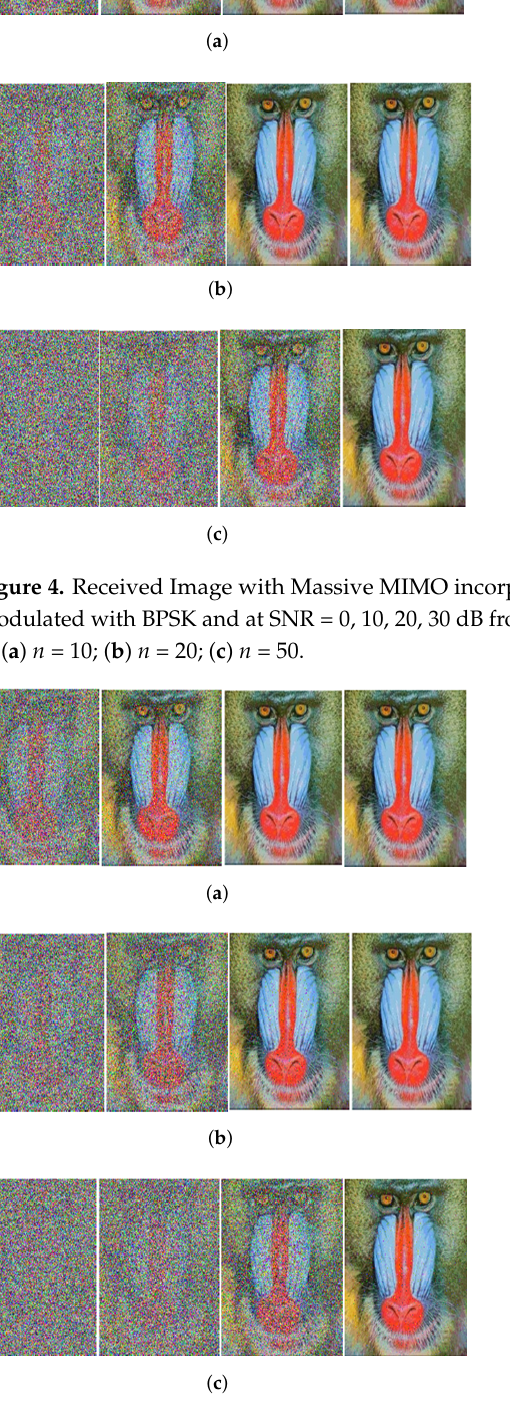
Figure 5. Received image with massive MIMO incorporated FFT-OFDM over a Rayleigh channel, Modulated with QPSK and at SNR = 0, 10, 20, 30 dB from Left to Right for different number of users, n . ( a ) n = 10; ( b ) n = 20; ( c ) n =